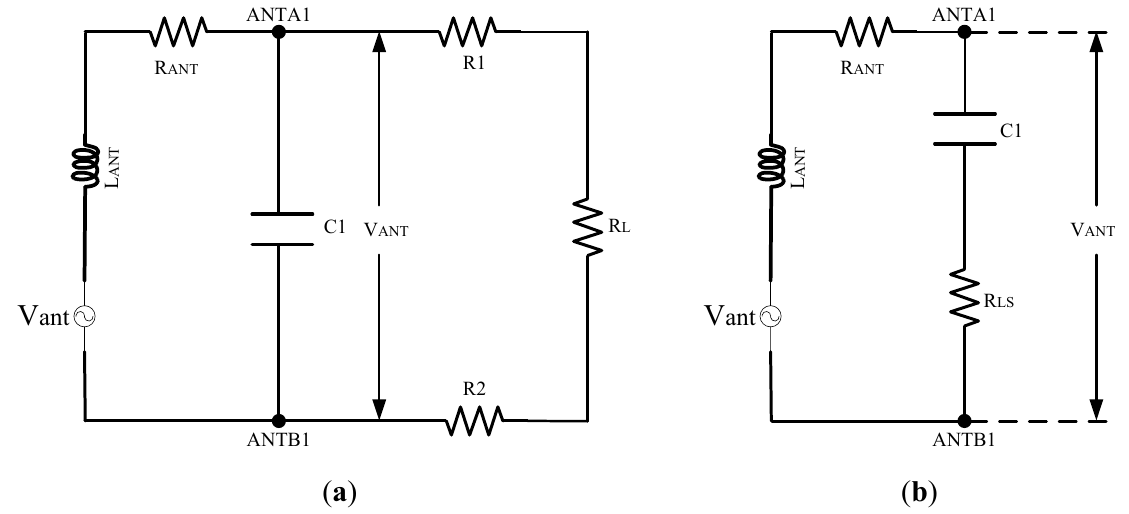
Figure 3. ( a ) Equivalent circuit of the NMOS gate cross-connected bridge rectifier; ( b ) Equivalent circuit of (a) after parallel to serial impedance